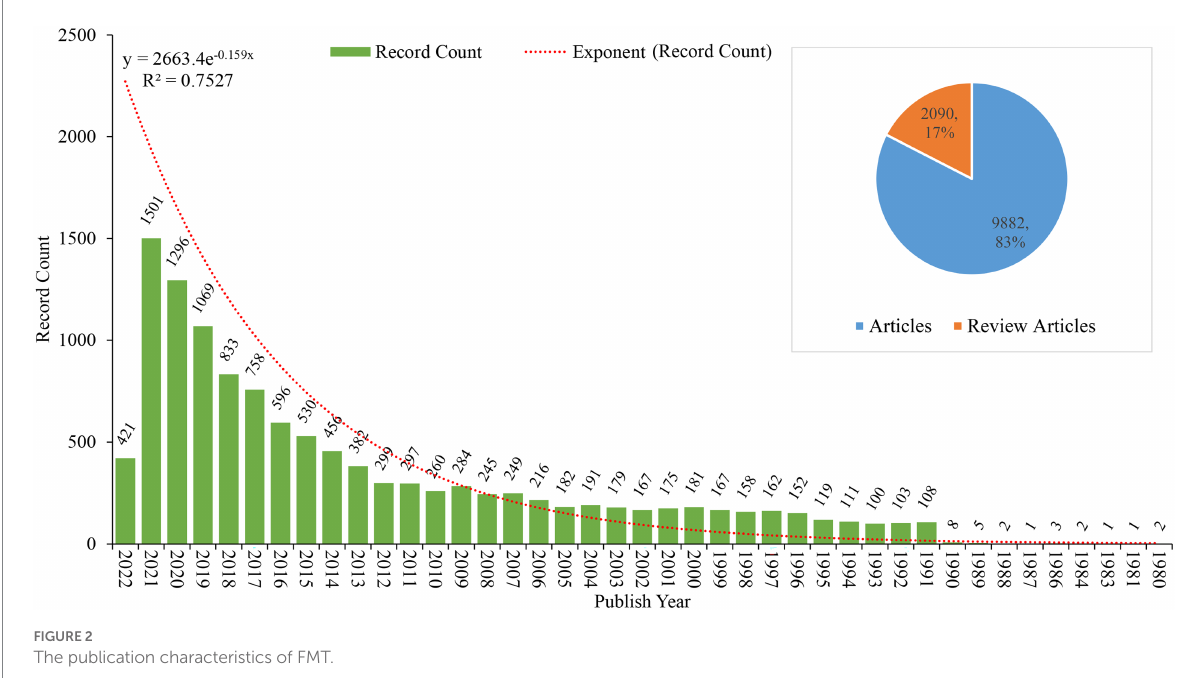
FIGURE 2 The publication characteristics of